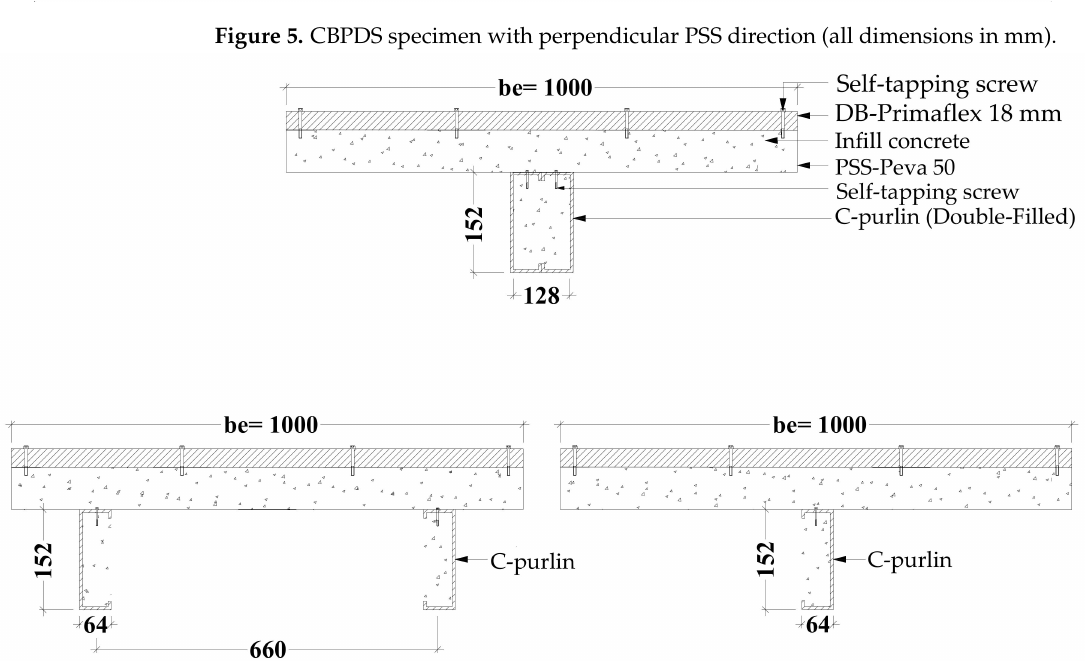
Figure 6. CBPDS cross-section with perpendicular PSS direction (all dimensions in